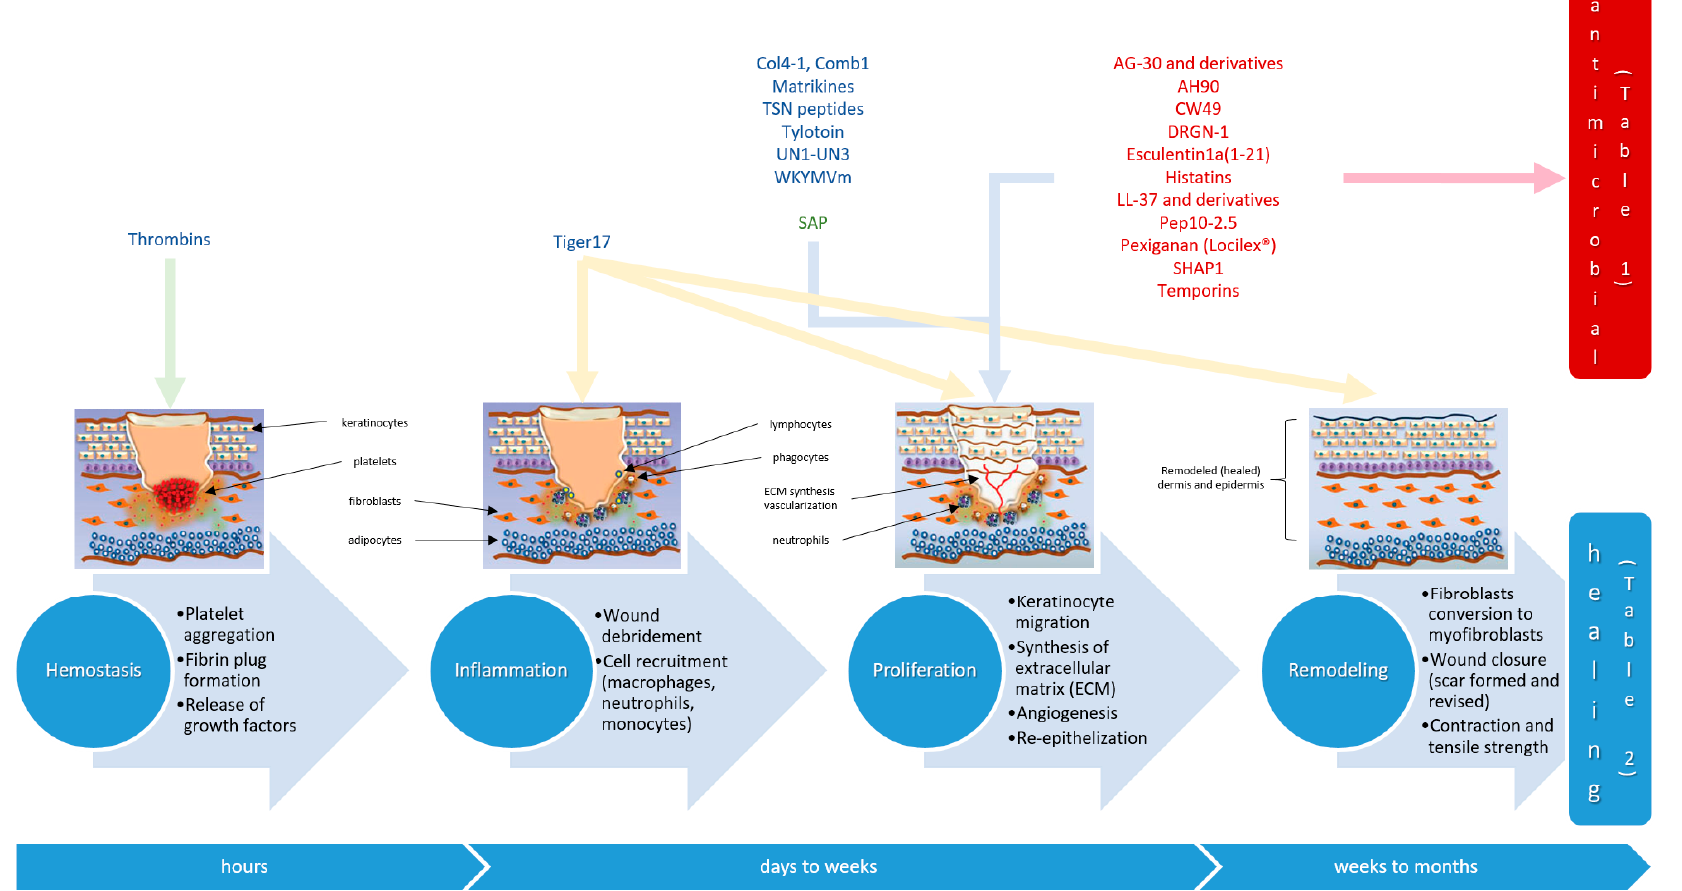
Figure 1. Schematic overview of major stages of wound-healing. Most wound-healing peptides were found to act on one or more biochemical pathways of the proliferation stage, although a few have been reported to act either on earlier stages (e.g., thrombin-related peptides) or on multiple stages (e.g., Tiger17)–see text. Examples of wound-healing antimicrobial peptides (Table 1) in dark red, and of wound-healing non-antimicrobial peptides (Table 2) in dark blue; SAP: self-assembling peptides (green).